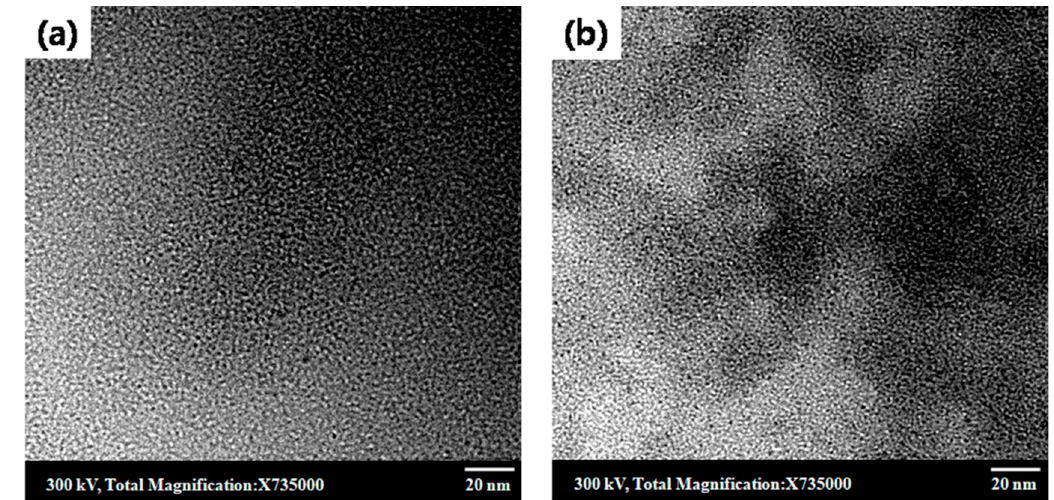
Figure 3. TEM images of ( a ) qPPO/D-Cel7, ( b ) qPPO/DG-Cel7, and both are stained with WO 42 ⁻ .